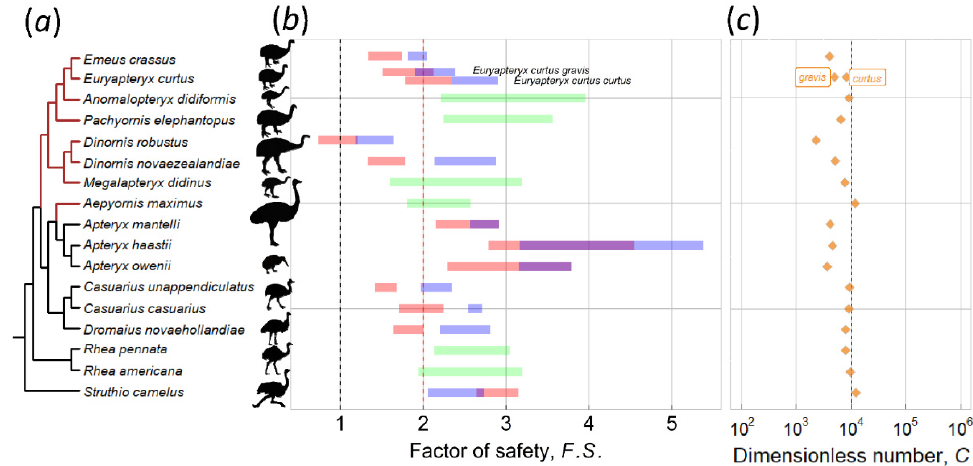
Figure 4. Factor of safety F.S. , C number and the phylogenetic relationship of 18 ratite species. The phylogenetic tree was plotted with cladogram using ggtree [40,41] and the nearby graph was plotted by package ggplot2 [42]. ( a ) phylogeny of ratites is based on a tree of Mitchell et al. [7], and phylogeny of moa is supplemented by Bunce et al. [30]. ( b ) the pink bar indicates the case of incubation by females, whereas blue indicates incubation by males. The purple bar in some species indicates F.S. overlap of two sexes, whereas green indicates species with no sexual size dimorphism. ( c ) the C numbers for ratites were predicted by FEA simulations. See Supplementary Dataset for details on the source of bird images (Table S1).